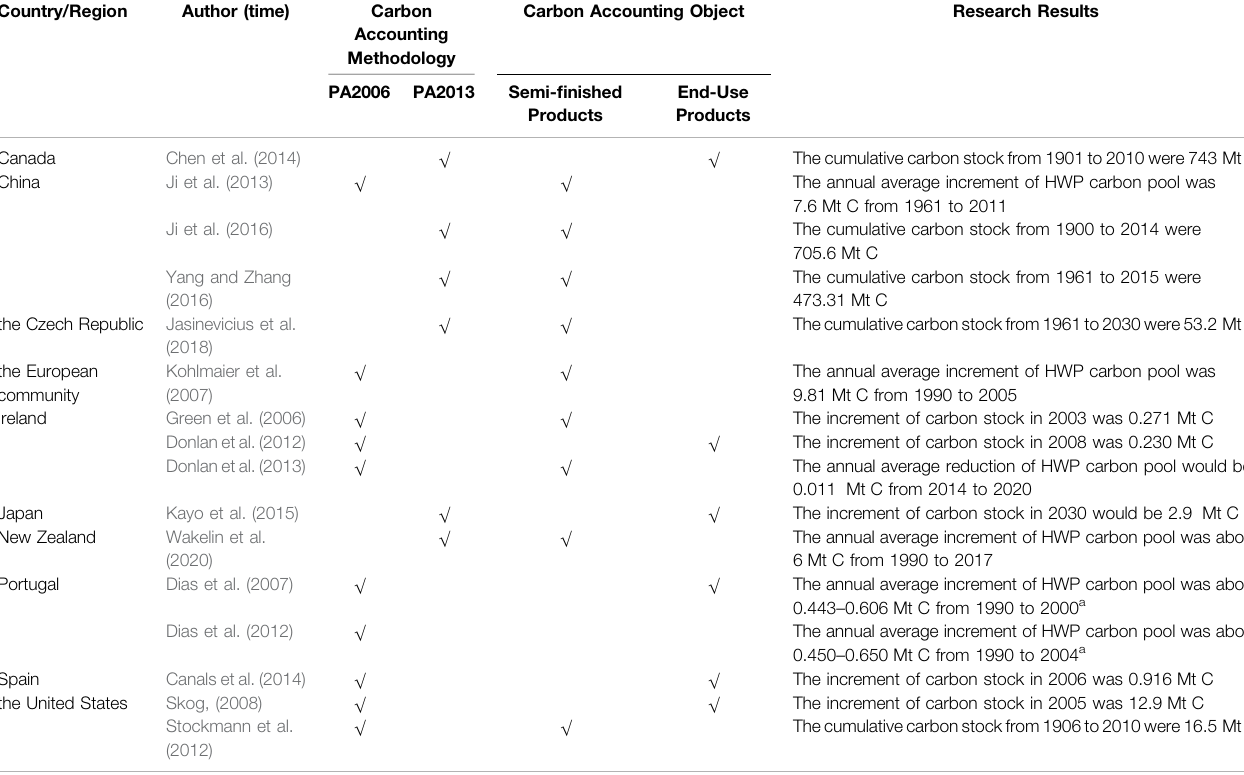
TABLE 1 | Application of Production Approach in various countries/regions when quantifying the carbon stock of HWP in